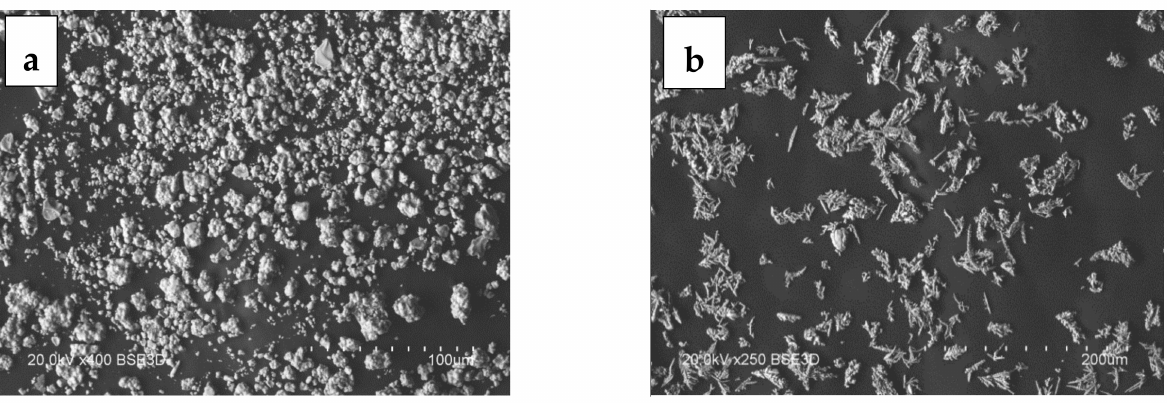
Figure 1. Micrographs of original Al 2 O 3 ( a ) and Cu ( b ) powders used to fabricate the